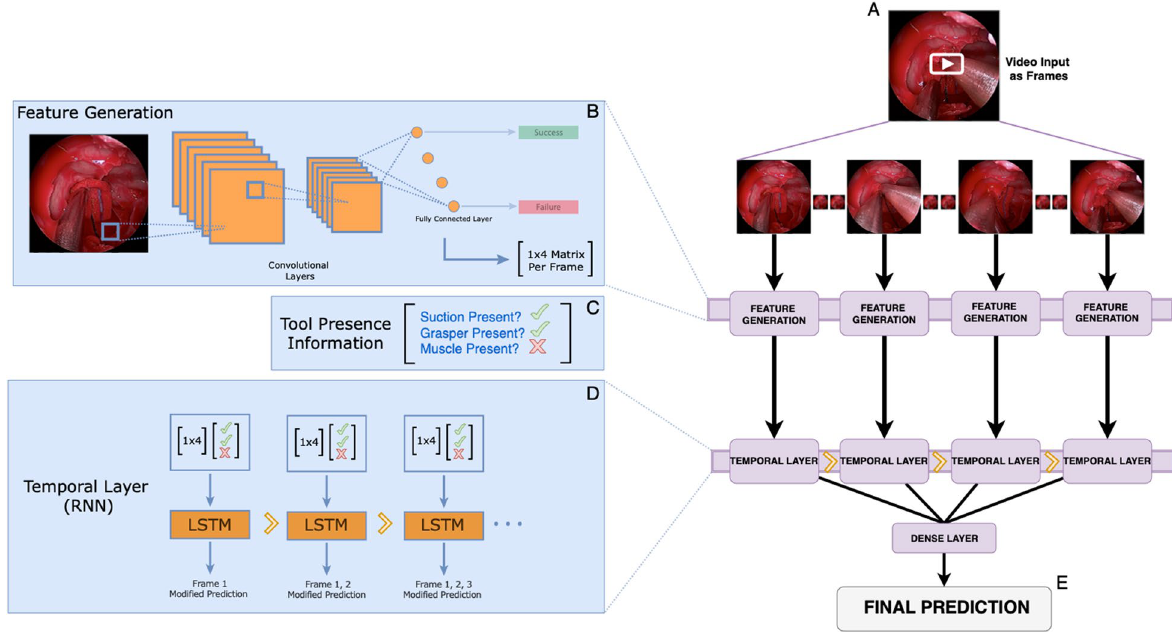
Figure 1. SOCALNet architecture. Deep learning model used to predict blood loss and task success in critical hemorrhage control task. ( A ) Video is snapshotted into individual frames. ( B ) A pretrained ResNet convolutional neural network (CNN) is fine-tuned on SOCAL images from ( A ), to predict of blood loss and task success in each individual frame. The penultimate layer of the network was removed and a 1 × 4 matrix of values predictive of success/failure or BL was obtained. This is repeated for all frames, generating a new matrix with N (number of frames) rows and 4 columns. Output matrix from ( B ) and Tool Presence Information ( C ) [e.g. ‘Is suction present? Yes (check); is Muscle present? No (X), etc.; encoded as 8 binary values per frame (Nx8)] is input into a temporal layer. ( D ) Temporal layer: Long-short-term memory (LSTM) modified recurrent neural network allowing for temporal analysis across all frames. The 2D matrix of: features from the ResNet and Tool Presence Information (‘check mark’, ‘X’) from each frame are fed into the Temporal Layer. All LSTM predictions are consolidated in one dense layer and ( E ) a final prediction of success/failure, and blood loss (in mL) is